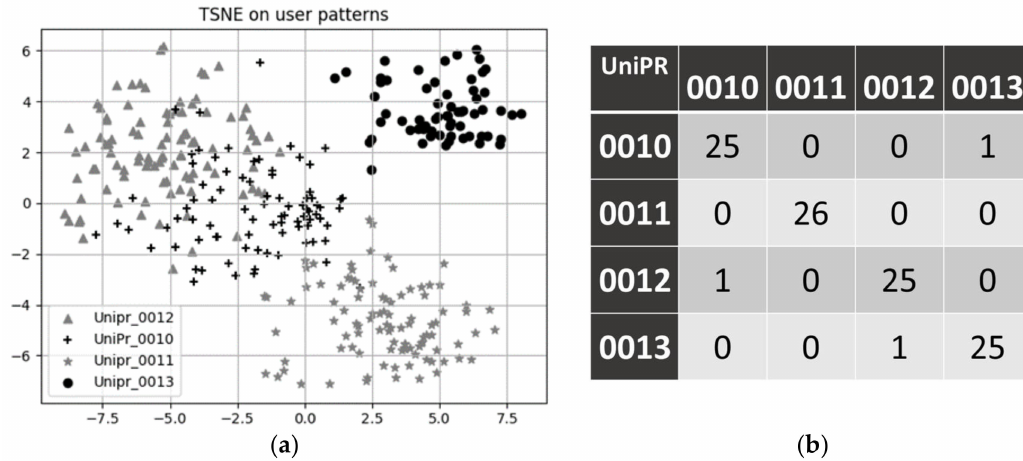
Figure 6. ( a ) 2-D visualization of daily living patterns as projected by the t-SNE manifold-learning algorithm; and ( b ) the confusion matrix, on the test set, for the user classification